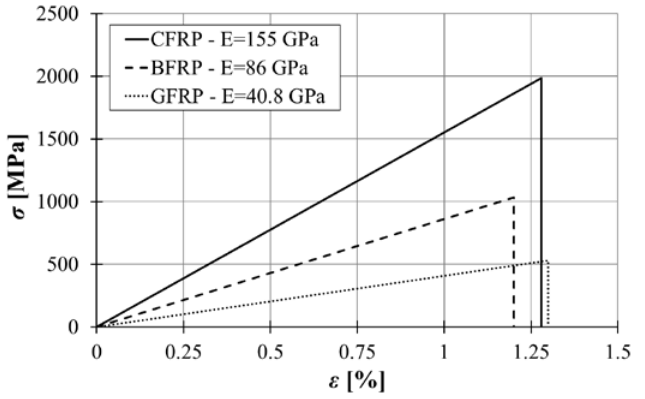
Figure 6. Constitutive relationships of the retrofitting composite materials.